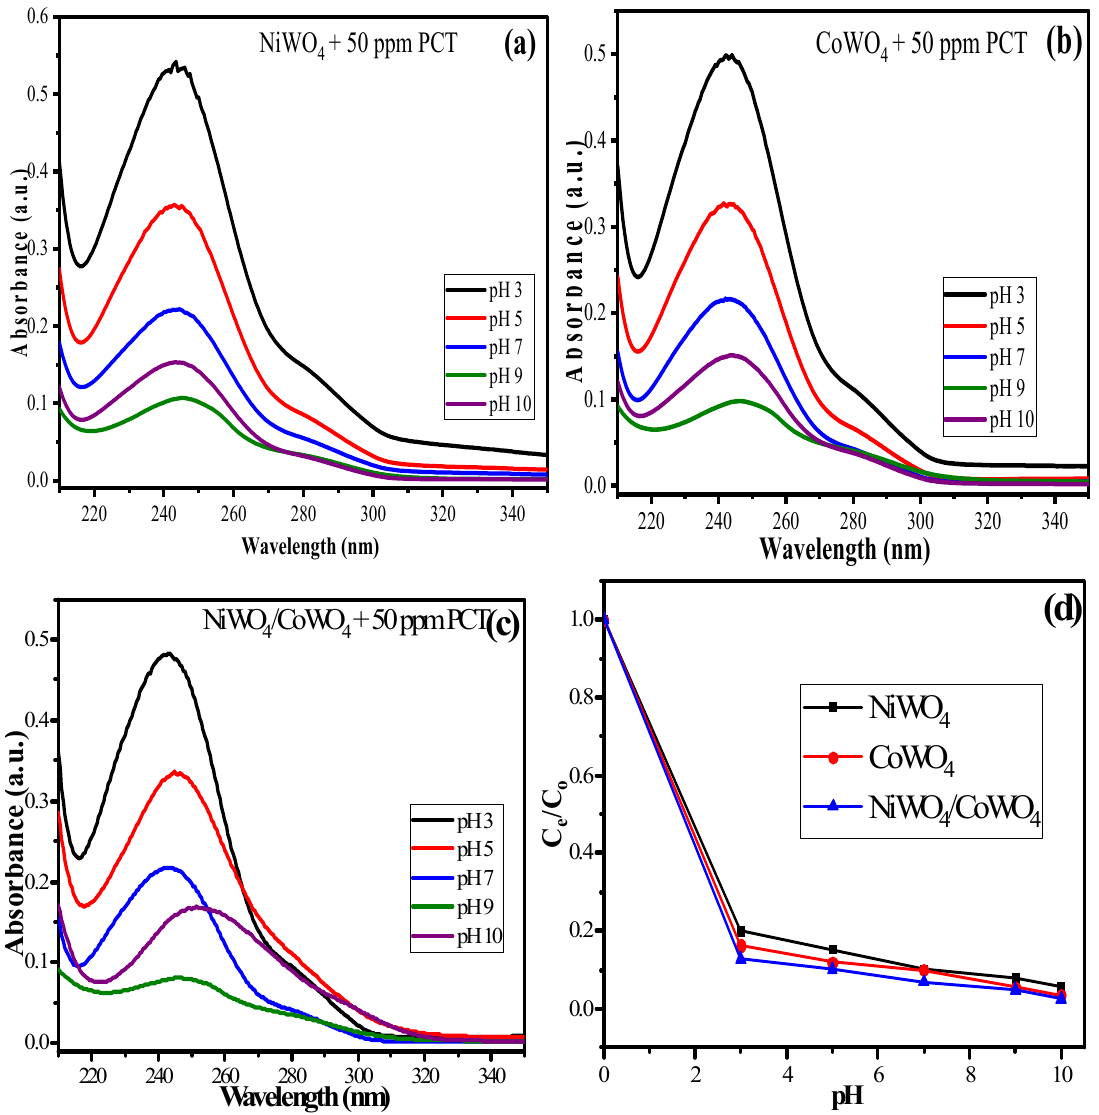
Figure 9. Effect of variable pH of the media (3–10) using 50 ppm PCT for 10 mg of ( a ) NiWO 4, ( b ) CoWO 4, ( c ) NiWO 4 /CoWO 4 NC, and ( d ) C e /C o vs pH of the medium plot.